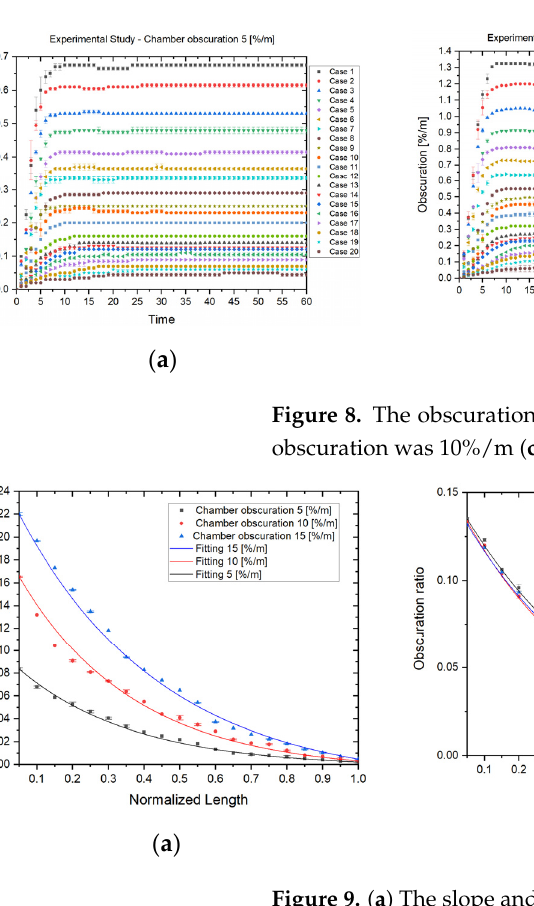
Figure 9. ( a ) The slope and normalized length correlation; ( b ) the obscuration ratio and normal- ized length correlation; ( c ) the slope and obscuration ratio correlation.